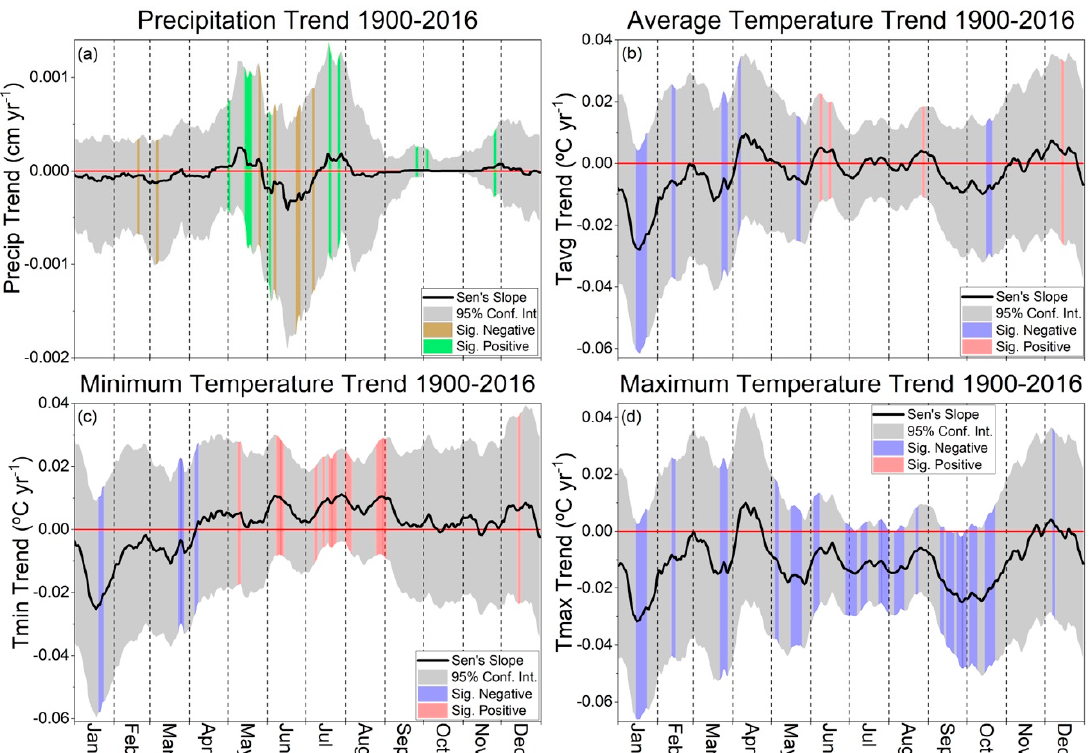
Figure 4. Centered three-week moving averages of ( a ) daily precipitation, ( b ) average temperature, ( c ) minimum temperature, and ( d ) maximum temperature trends averaged across all eighteen stations between 1900 and 2016. Grey shading represents the 95% confidence interval. Brown and green (red and blue) shading represents statistically significant ( p < 0.05) daily precipitation (temperature) trends.